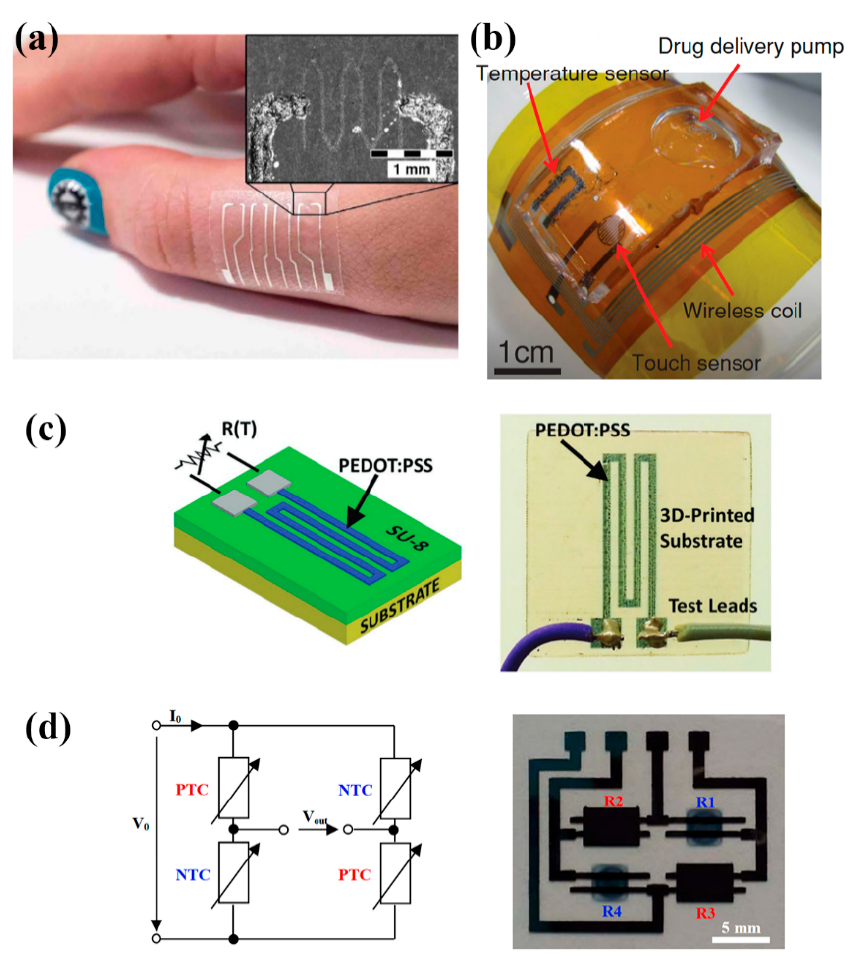
Figure 15. Various PEDOT:PSS-based temperature sensors, demonstrating a wide range of applications: ( a ) on-body temperature measurement patches (reproduced with permission from [46] copyright 2016, Springer-Nature); ( b ) (reproduced with permission from [47] copyright 2014, Wiley); ( c ) different substrates such as 3D-printed structures can be utilized as well (reproduced with permission from [56] copyright 2017, Wiley); ( d ) printed thermistors on PEN in bridge configuration (reproduced with permission from [55] copyright 2016, Elsevier).